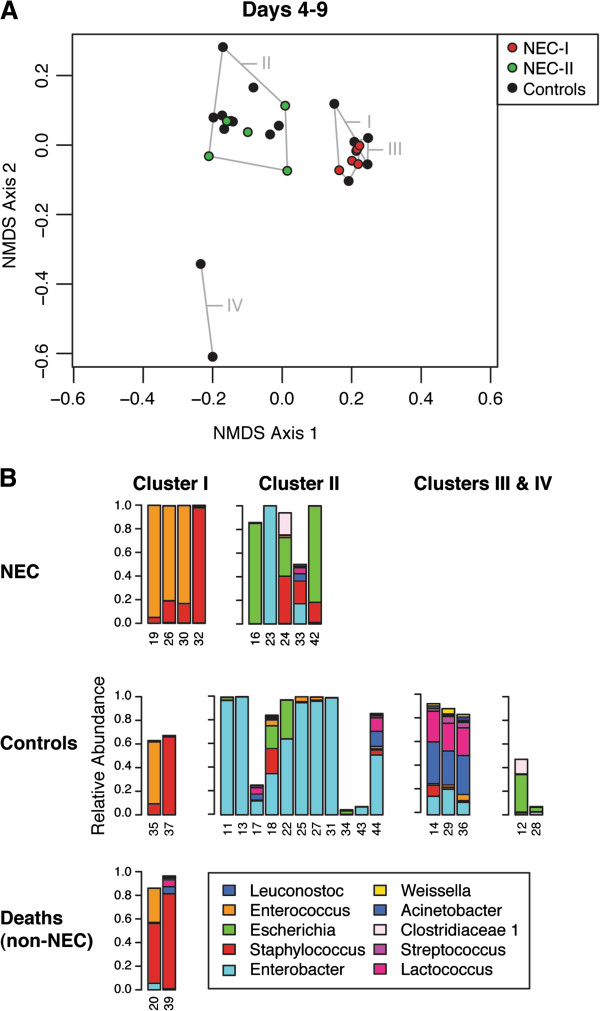
NMDS ordination of microbial communities for days 4 to 9 of life. (A) This ordination was based on weighted UniFrac beta diversity and run with three dimensions in the vegan package of R, resulting in a stress of 4.06. Control samples are shown in black and NEC and non-NEC deaths are shown in red for those included in Cluster I or green for those samples included in Cluster II. Clusters of samples with similar microbial composition were systematically identified using the Ward minimum variance method. These clusters are labeled using roman numerals I through IV. All NEC cases were found in either Cluster I or Cluster II only. The samples from the two non-NEC deaths are also found in Cluster I. (B) Bars indicate the relative abundance of the ten most common genera in samples from individual infants, whose study numbers are noted on the horizontal axis. Samples are grouped according to case or control status and the cluster in which they were identified. NEC: necrotizing enterocolitis; NMDS: non-metric dimensional scaling.